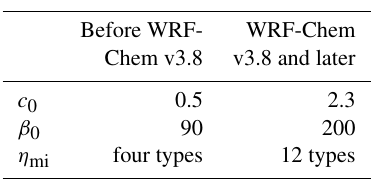
Table B1. Differences in Shao2011 dust emission scheme between different WRF-Chem